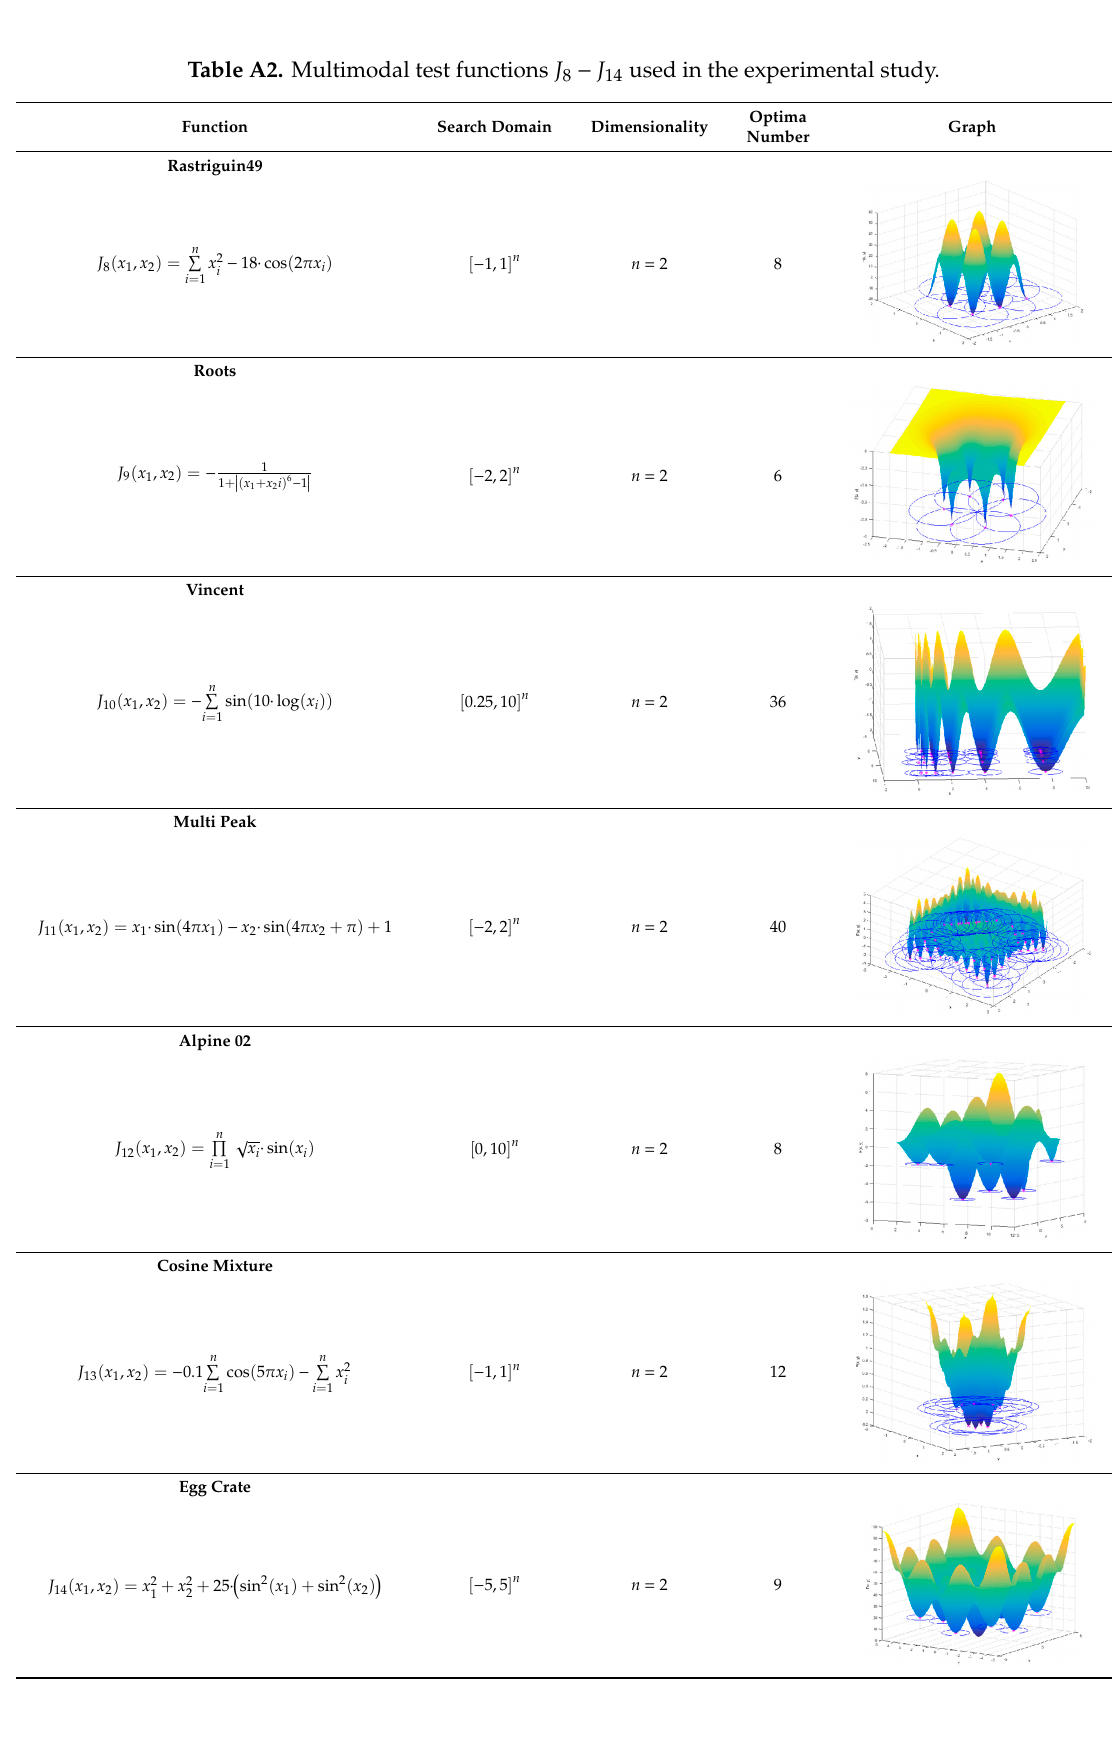
Table A2. Multimodal test functions 8 14 J J − used in the experimental study.